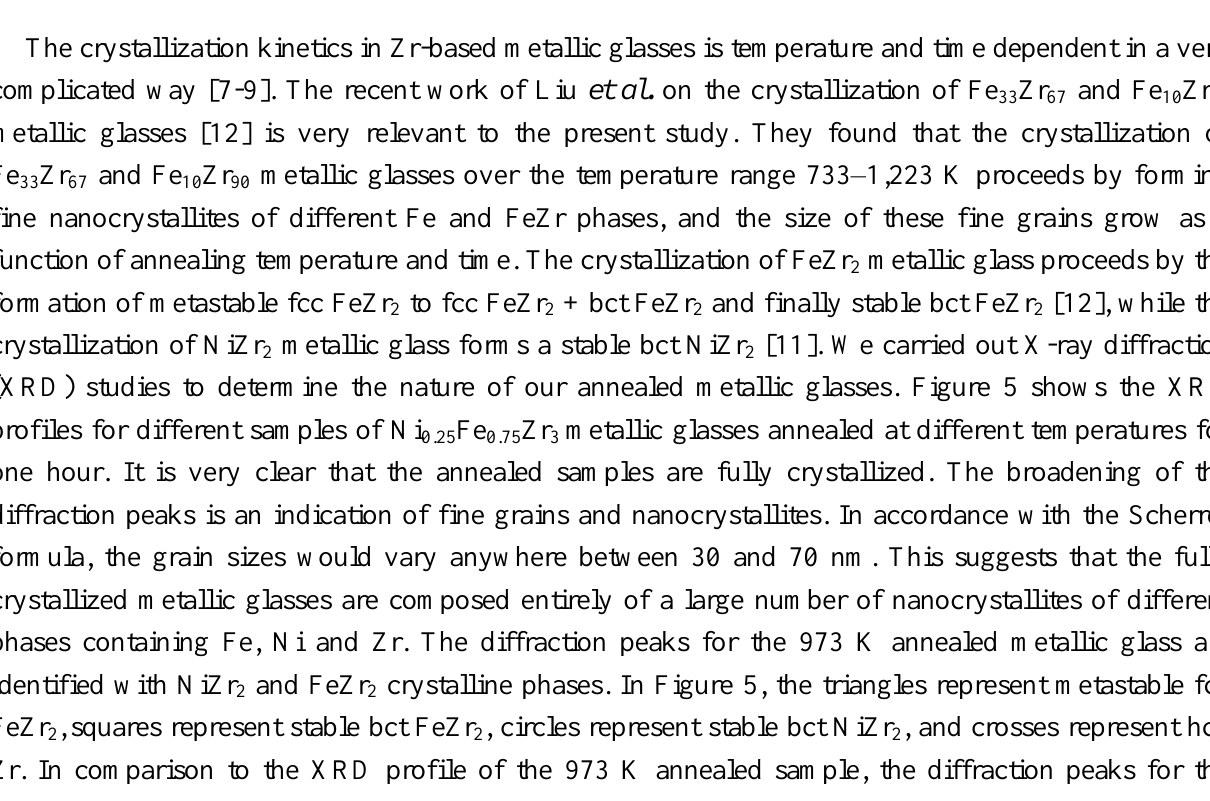
Fe Zr metallic 0.25 0.75 3